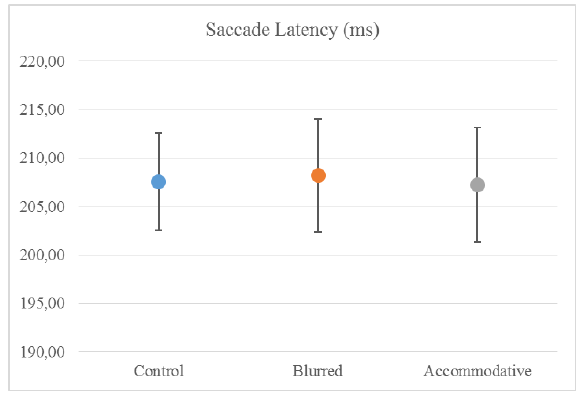
Figure 1. Saccade Latency were similar across conditions .